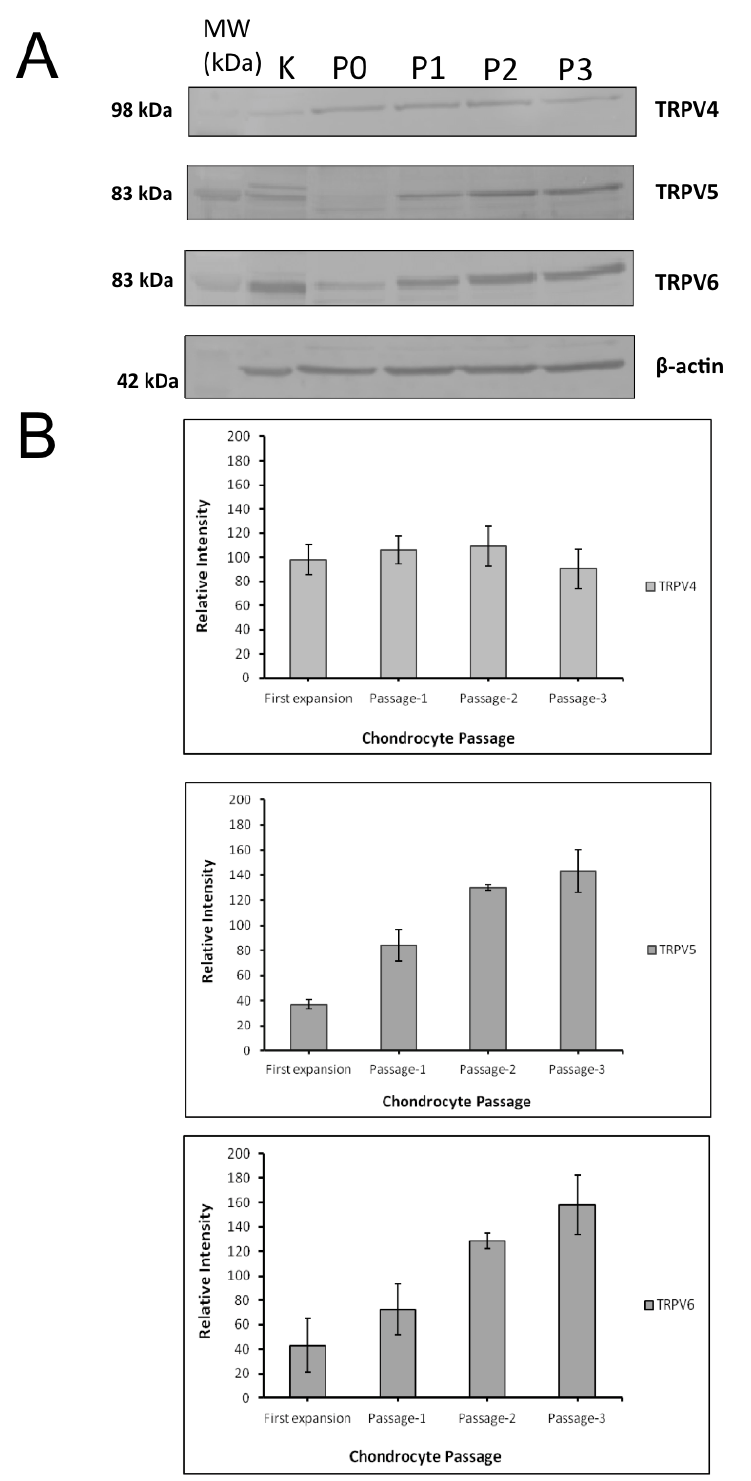
Figure 2. ( A ) Western blot analysis of total chondrocytes lysate (25 μg/lane) from first expansion (P0) and serial passages (P) 1–3. Kidney was used as a positive control. Western blotting confirmed the expression of TRPV4, TRPV5 and TRPV6 proteins in different passages. B. Image analysis of western blots. No significant change in expression profile was observed in TRPV4 among different passages. TRPV5 and TRPV6 expression was significantly upregulated with time and passage in culture ( P <